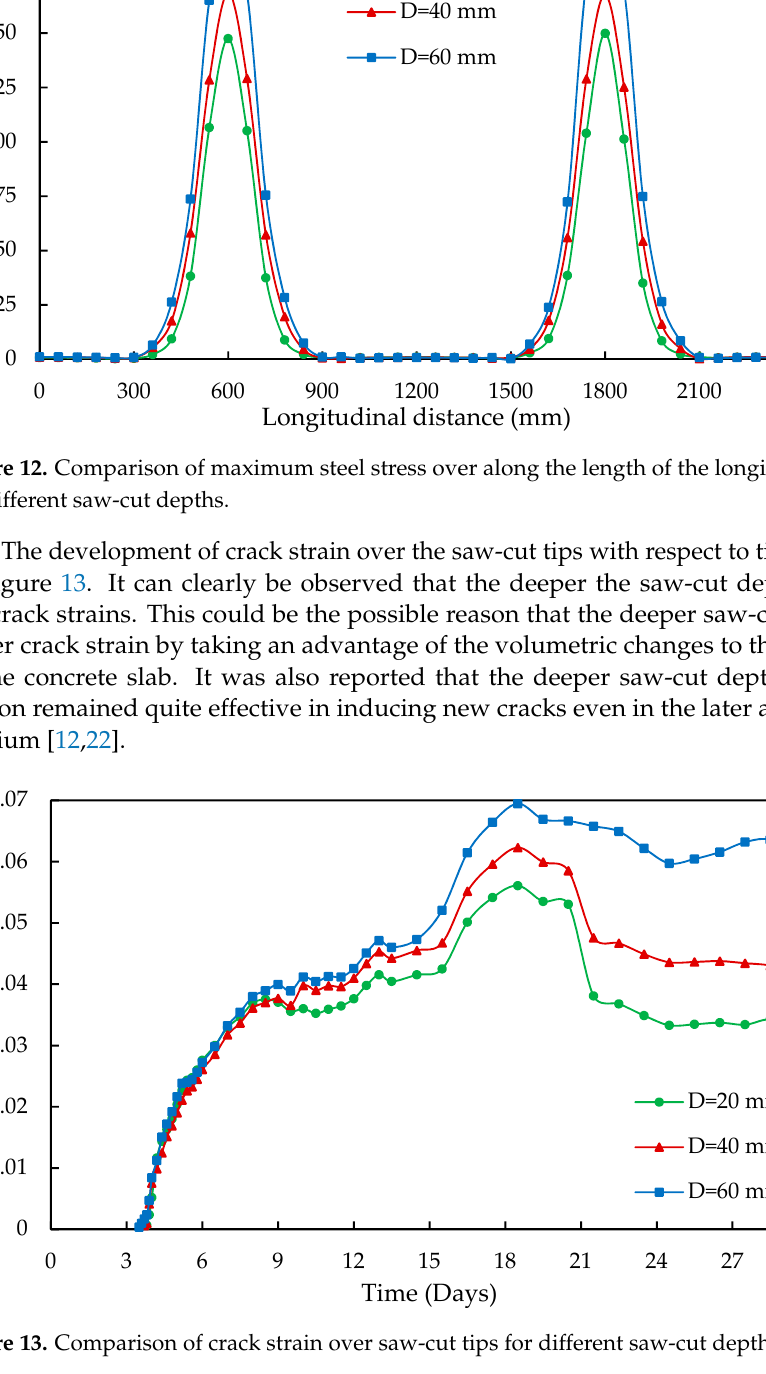
Figure 13. Comparison of crack strain over saw-cut tips for different saw-cut depths.